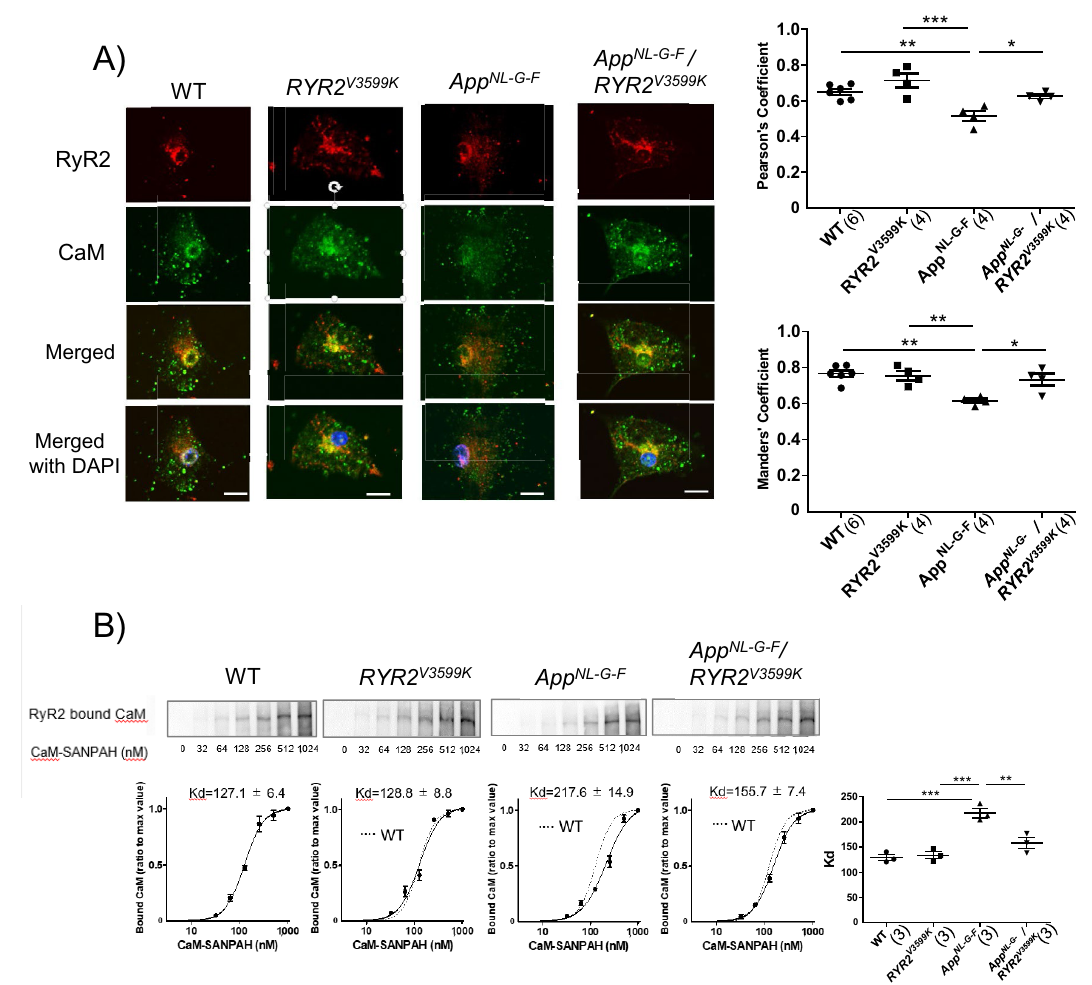
Figure 3. CaM-RyR2 interaction in WT, App NL-G-F , RYR2 V3599K , and App NL-G-F / RYR2 V3599K mice. ( A ) Representative images of endogenous CaM, and RyR2 in neuronal cells.; (Left) immuno-staining of RyR2 (red), immuno-staining of CaM (green) and merged image (Right) the summarized data of the Pearson’s and Manders’ coefficients. Scale bars: 10 μM. Values for individual mice are plotted together with mean ± SEM. N = 25–48 cells from 4–6 mice. Parentheses indicate the number of mice. * p < 0.05, ** p < 0.01 (one-way ANOVA with post-hoc Tukey’s multiple comparison test). ( B ) (Top) Representative immunoblots of the RyR2-bound CaM–SANPAH (a photoreactive crosslinker; N-succinimidyl-6-[4 ′ -azido-2 ′ -nitrophenylamino]). (Bottom) Summarized data of CaM binding to RyR2 as a function of the concentration of CaM–SANPAH. CaM binding was expressed as the ratio to the maximum binding at 1024 nM CaM. Dotted line means CaM binding curve in WT. Data represent means ± SEM of 3 mice. Parentheses indicate the number of mice. Full-length blots are presented in Supplementary Fig. 11. ** p < 0.01, *** p < 0.001 (one-way ANOVA with post-hoc Tukey’s multiple comparison